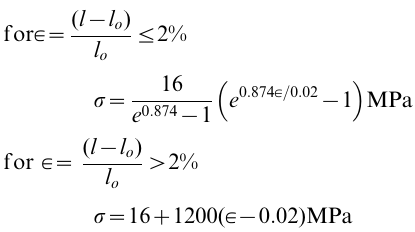
nodes i and j are computed as { EA [ and EA [ . For the the string collapses in compression, both F i and F j are zero.